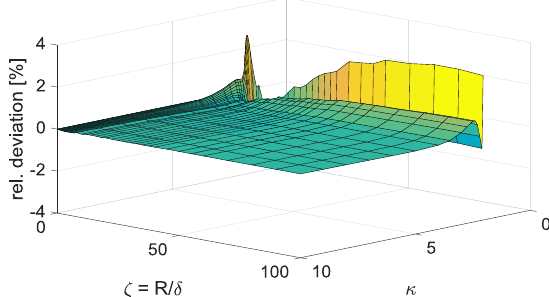
Figure 8: Pseudo 3D plot of the relative deviation of the analytical approximation from the reference data in